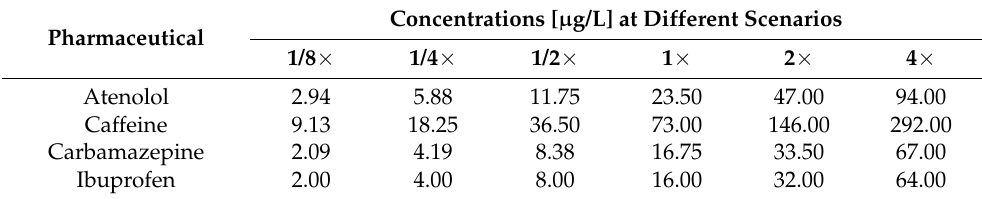
Table 1. Environmentally relevant pharmaceutical concentrations and scenario testing